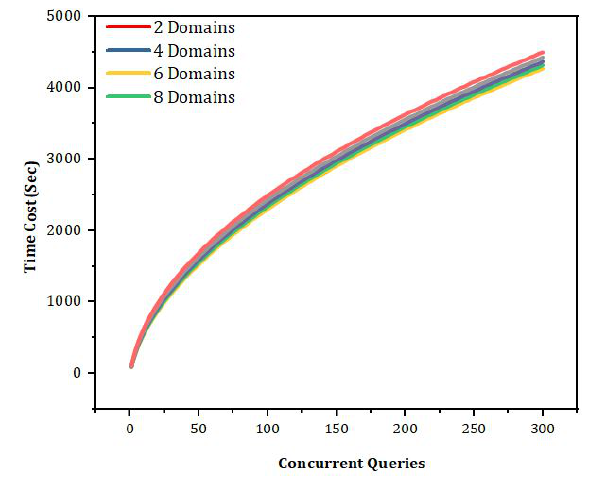
Figure 13. The impact of various domains over the time cost and number of transaction based on number of concurrent queries and requests.